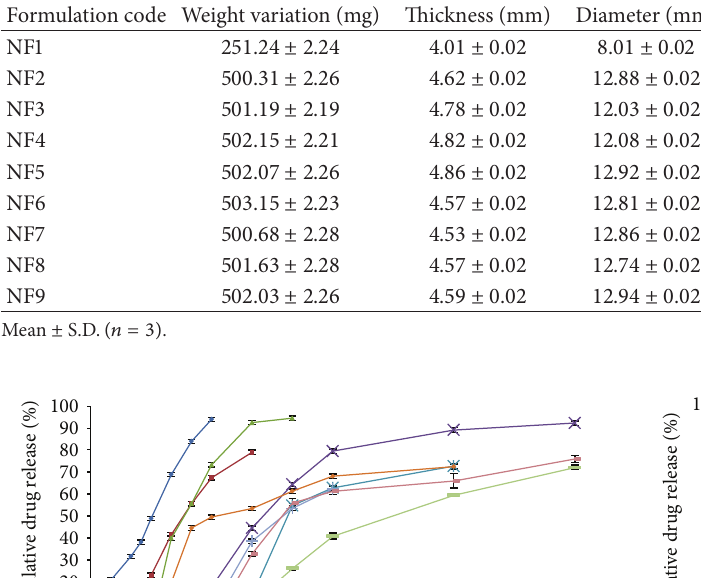
Table 3: Physicochemical parameters of naproxen sodium core, press-coated tablets, and enteric-coated tablets.